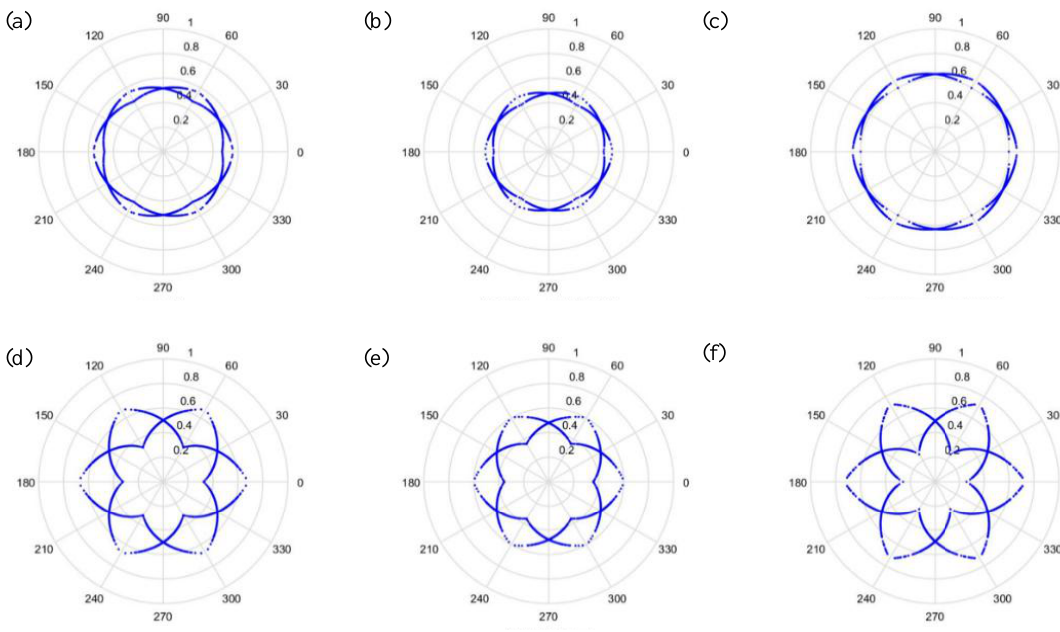
Figure 8. Results by improved formula when t = 0 and sampling is at 1000 Hz / 1000 rpm. ( a ) Normal, ( b ) motor platform with one eccentric screw, ( c ) motor platform with two eccentric screws, ( d ) sanded ball bearings, ( e ) insufficient lubrication, and ( f ) worn ball bearings.